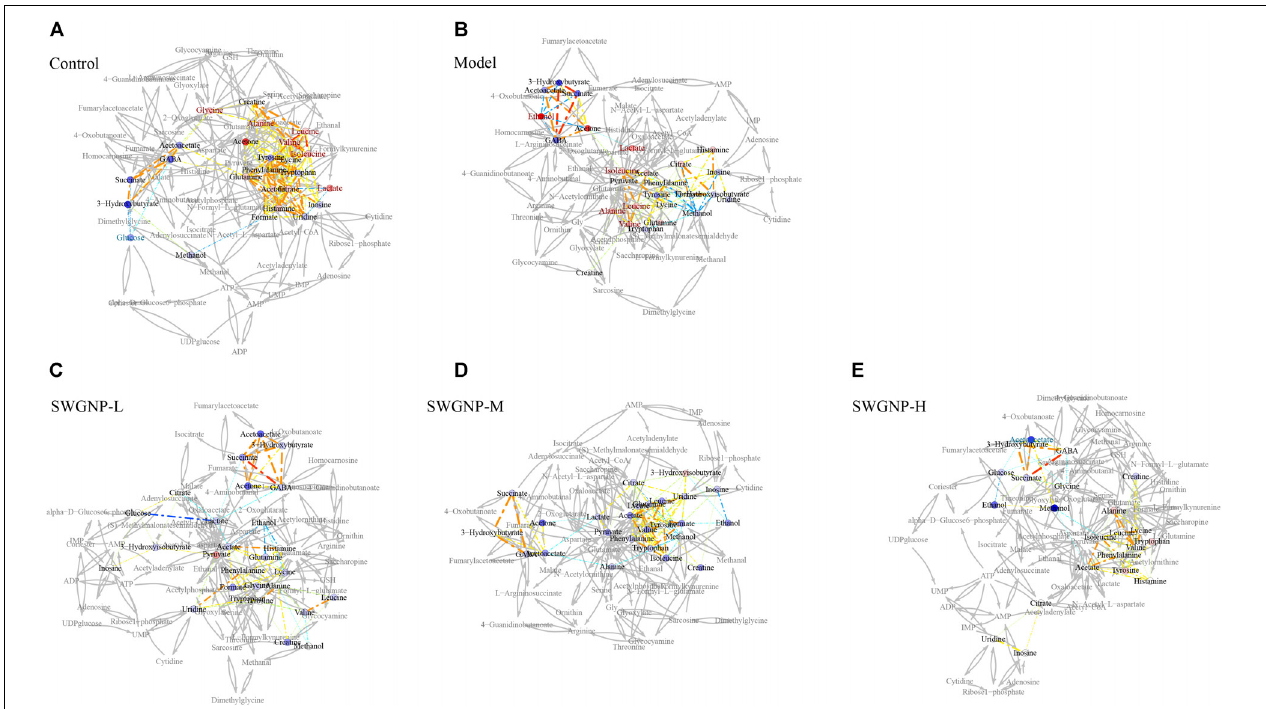
FIGURE 9 | Correlation network analysis of serum from control, model and three SWGNP treated groups. (A) Control: Normal control group; (B) Model: CCl 4 -induced liver fibrosis model group; (C) SWGNP-L: Low dose of SWGNP treatment group; (D) SWGNP-M: Medium dose of SWGNP treatment group; (E) SWGNP-H: High dose of SWGNP treatment group. NMR correlation was connected by dotted lines, colored according to Pearson correlation coefficient and auxiliary biochemical reaction by gray solid lines. Metabolites in red and blue represented significant increase or decrease. Circles were filled by the colors according to corresponding fold